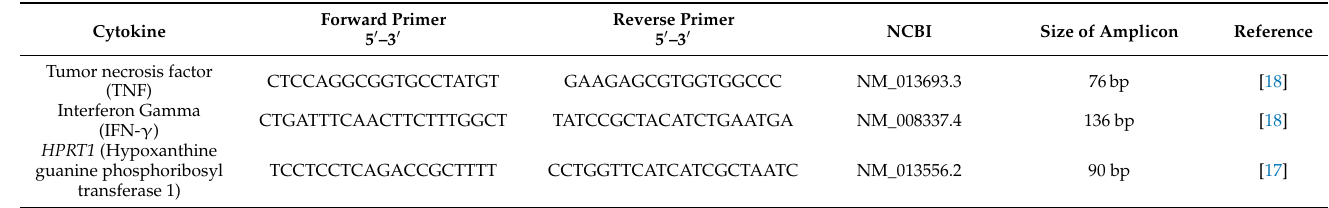
Table 3. Primers and expected Amplicon sizes for TNF and INF- γ toxicity